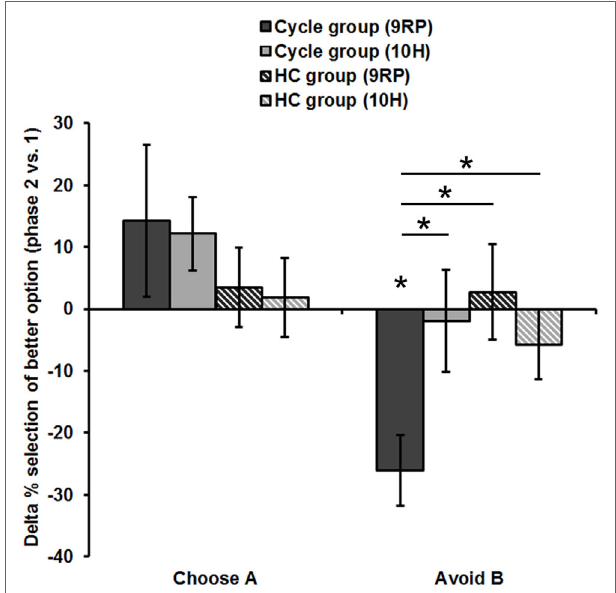
FigUre 2 | Difference in reinforcement learning capacity between phases (session 2). Displayed is the Delta of the late minus early FP and of the ON- minus OFF-phase, respectively. Only the 9RP genotype showed a significant phase-related change in punishment avoidance capacity. Significant differences ( p < 0.05, two-tailed) from zero and between genotypes and groups, respectively, are marked with an asterisk. Phase 1, early FP or OFF-phase; phase 2, late FP or ON-phase.